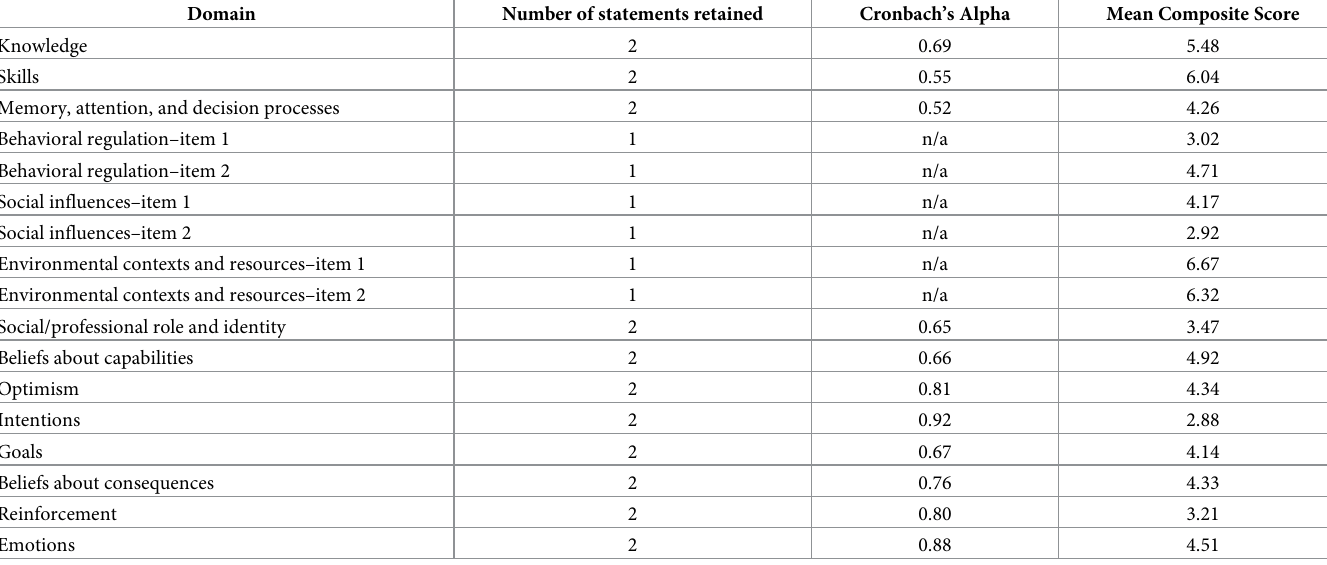
Table 5. Cronbach’s alpha and composite scores for the Theoretical Domains Framework: Diagnostic 2 survey about actual behavior.